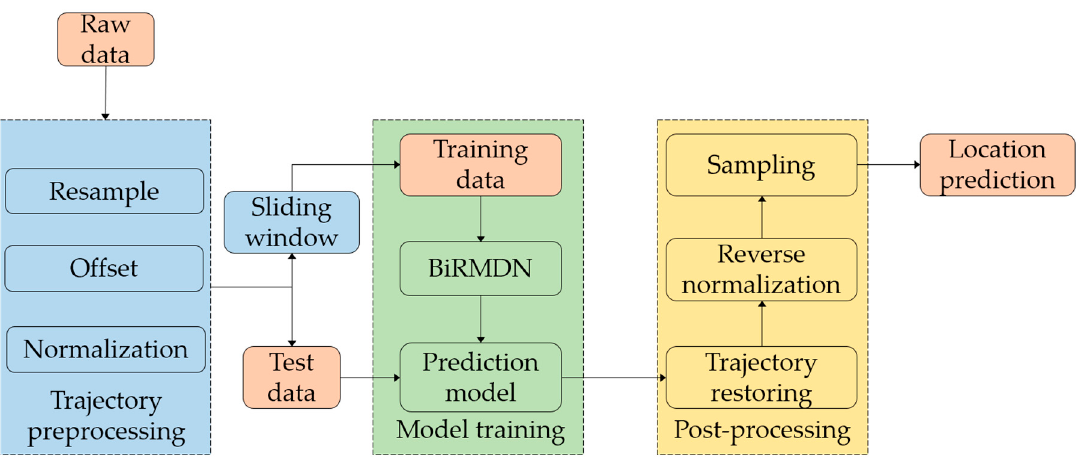
Figure 1. Process of the proposed method. BiRMDN: bidirectional recurrent mixture density network.